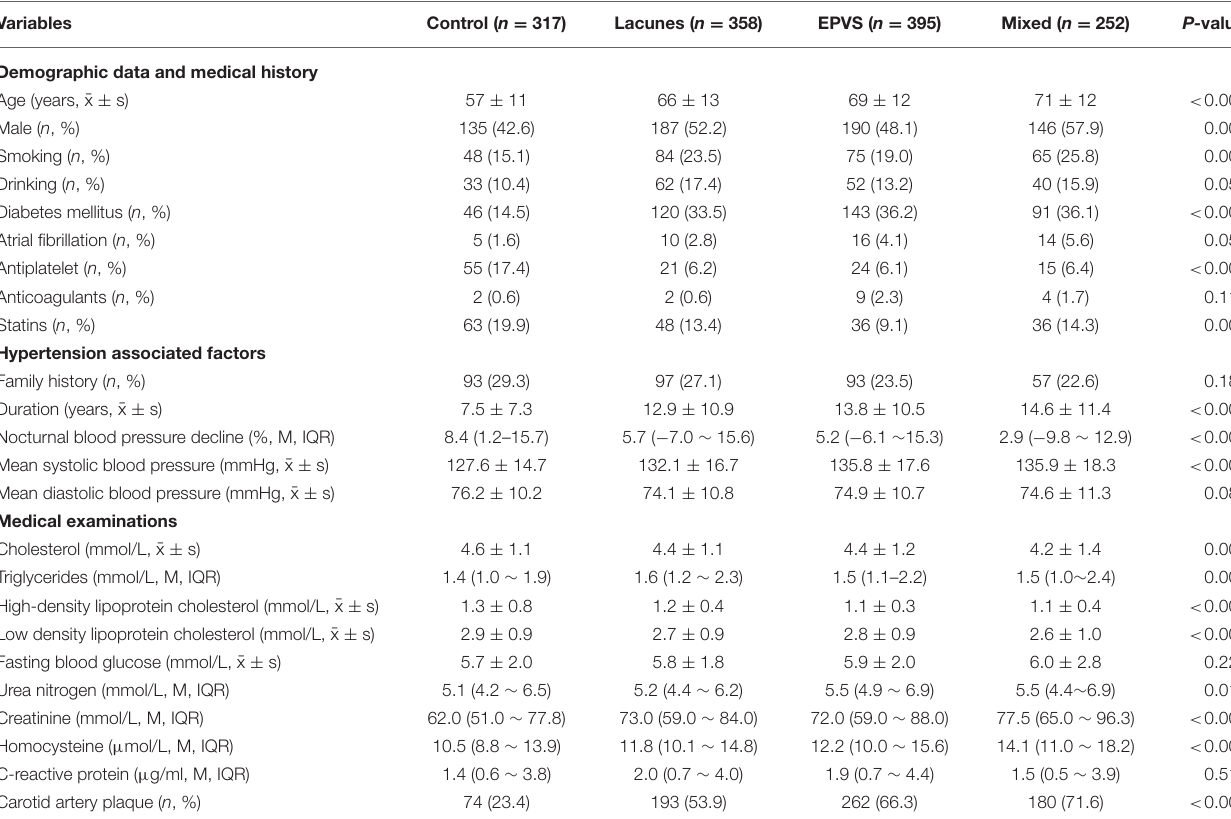
TABLE 1 | The comparison of demographic and clinical characteristics among groups.